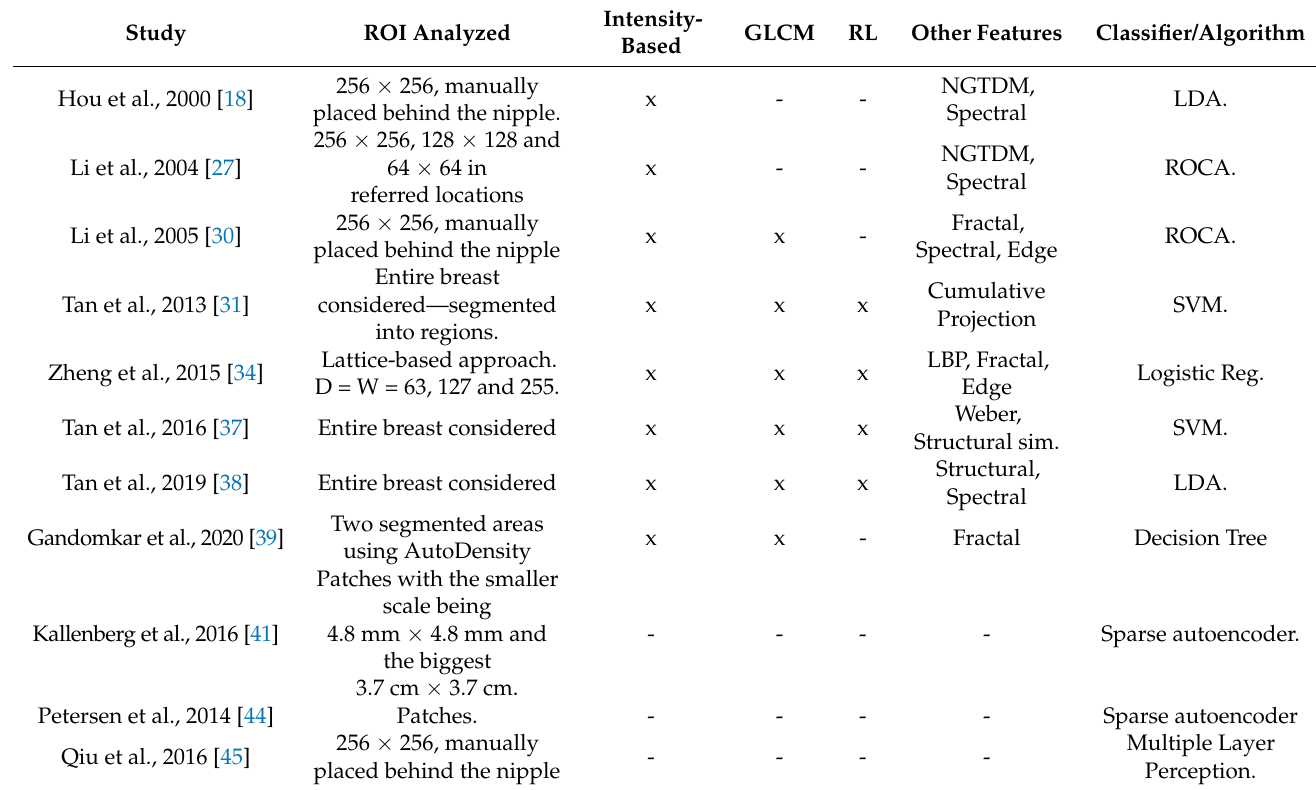
Table 2. Methods